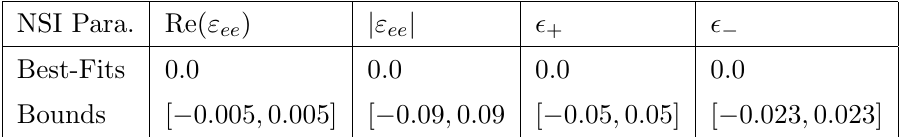
Figure 6 . Future prospects: boundaries on individual source NSI parameters " + ; (cid:0) , j " ee j , and Re( " ee ) are shown with 1 (cid:27) and 90% C.L. lines. The latter are listed in table 4.